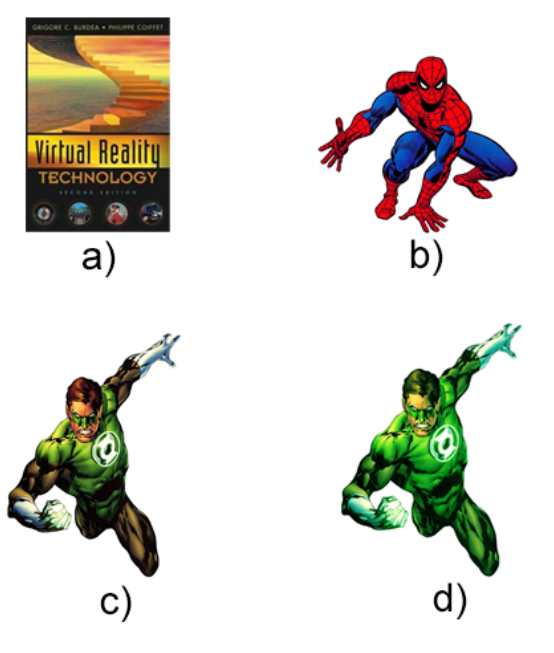
Fig. 4. (a) Template 1: Book, (b) Template 2: Spider-Man, (c) Template 3: Green Lantern, (d) Template 4: Modified Green Lantern